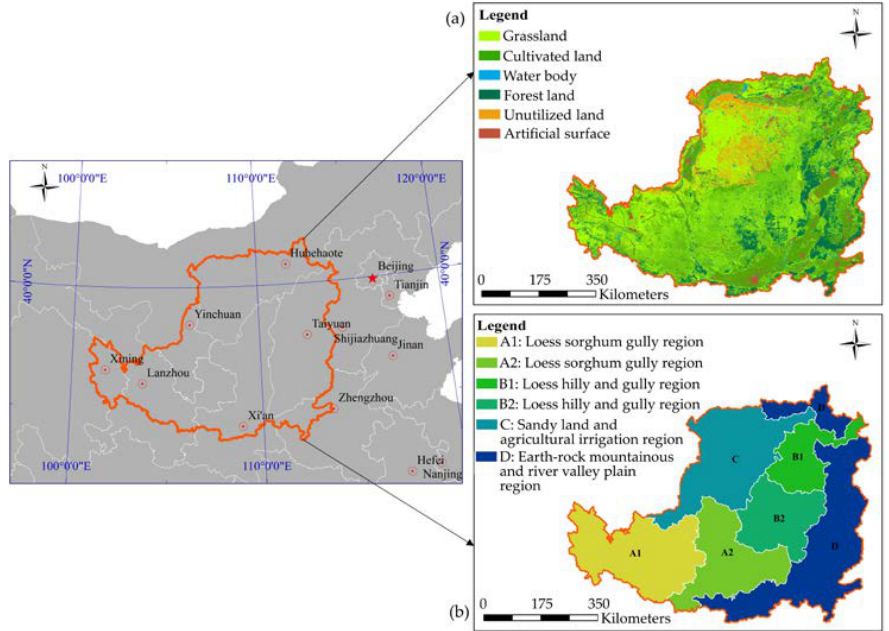
Figure 1. Geographical location, land cover, and ecoregions of the Loess Plateau. ( a ) shows the spatial distribution of land cover on the Loess Plateau. ( b ) shows the spatial location of six ecoregions (including two sub-regions) of the Loess Plateau. Table 1. Ecoregions of the Loess Plateau.